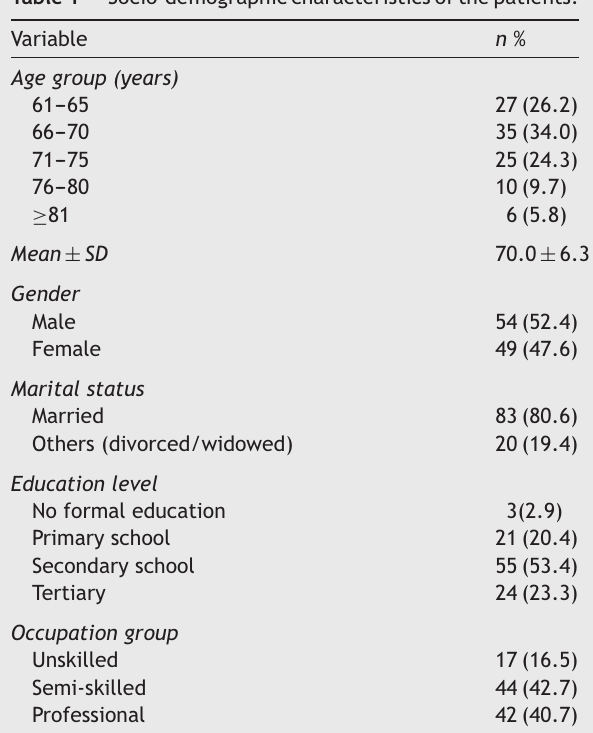
Socio-demographic characteristics of the patients.